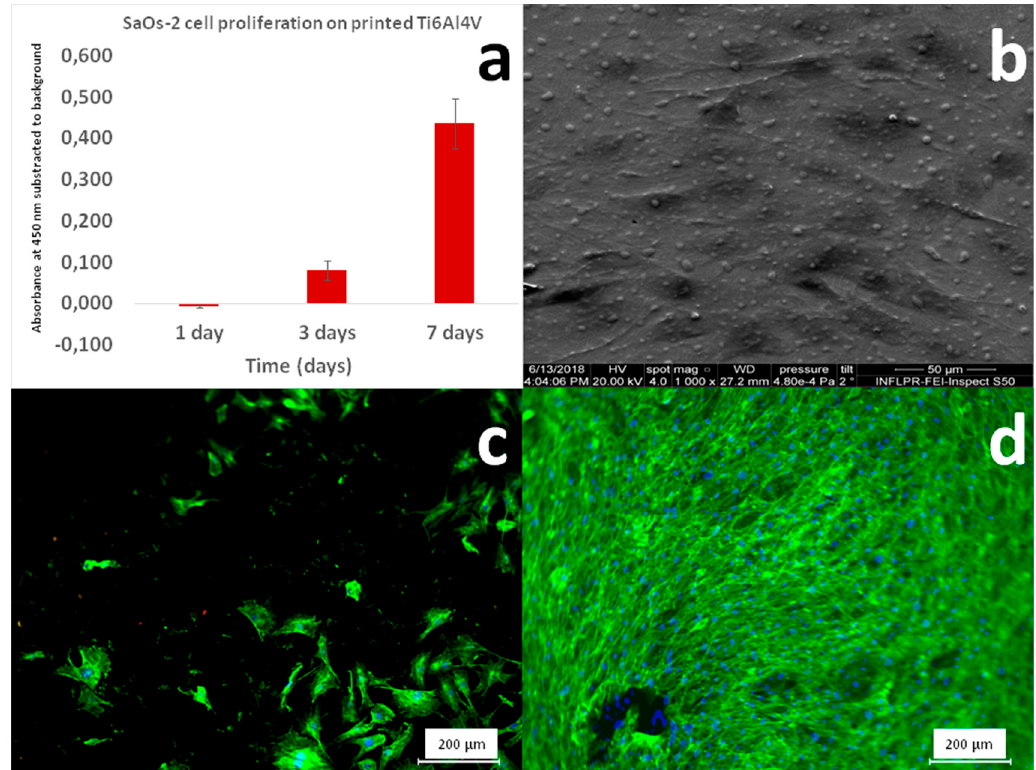
Figure 16. ( a ) MTS results for the SaOs2 cells grown on Laser Melting Deposition (LMD) printed Ti6Al4V; ( b ) SEM micrograph of SaOs2 cells 3 days after seeding on LMD printed Ti6Al4V; Fluorescence microscopy images of SaOs2 cells cultivated for ( c ) 1 day and ( d ) 3 days on the surface of LMD printed Ti6Al4V.